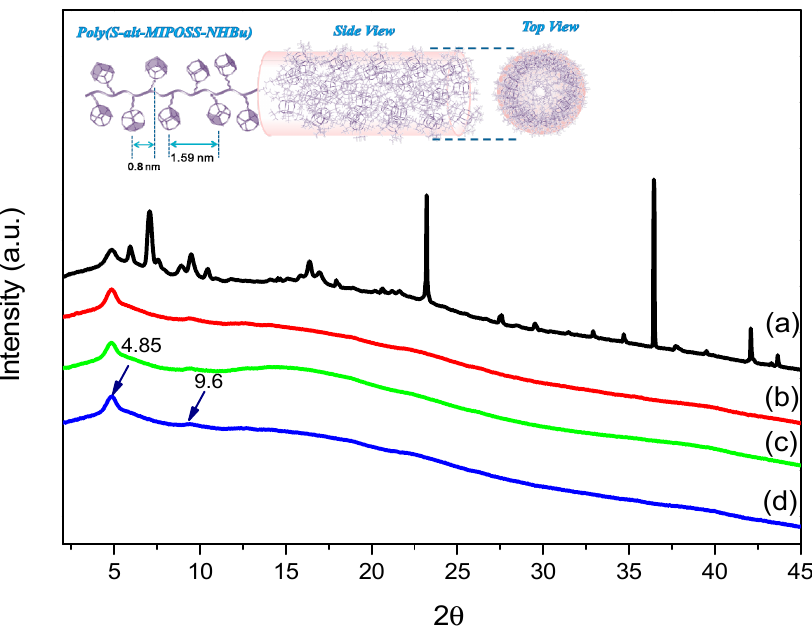
Figure 8. WAXD patterns of: ( a ) MIPOSS-NHBu; ( b ) poly(S- alt -MIPOSS-NHBu); ( c ) poly(AS- alt - MIPOSS-NHBu); and ( d ) poly(HS- alt -MIPOSS-NHBu). Inset Figure: the scheme about the d -spacing of poly(S- alt -MIPOSS-NHBu) alternating copolymer.